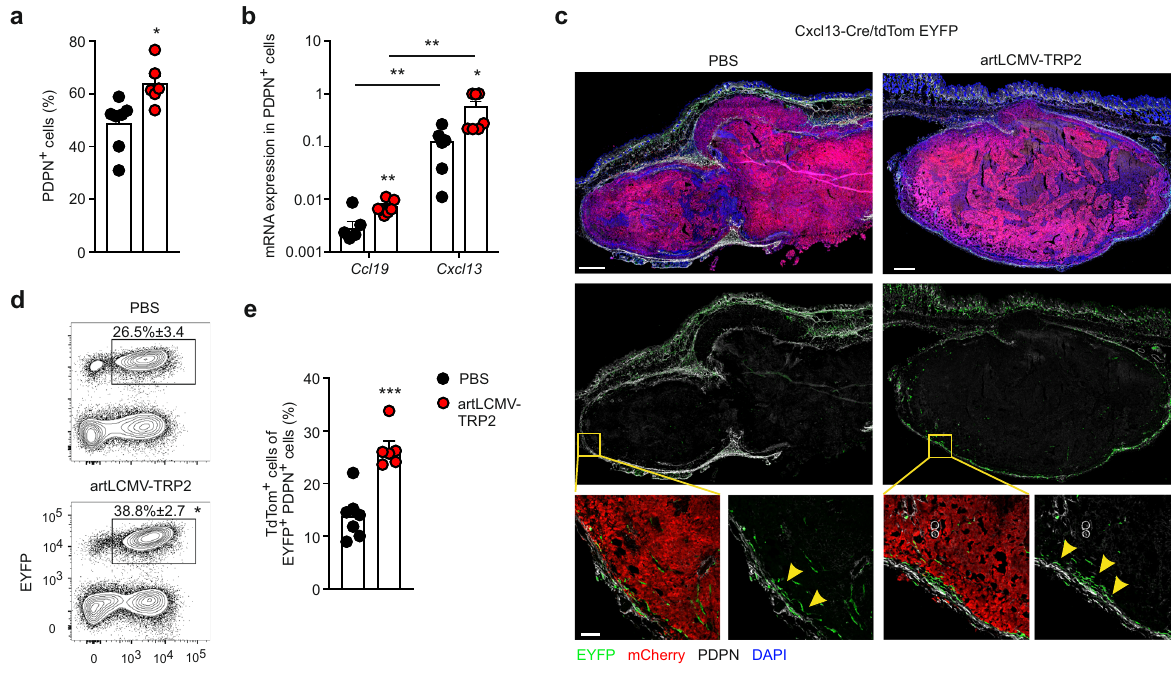
Fig. 4 artLCMV treatment induces Cxcl13 -expressing FSCs in the TME. Mice were inoculated with B16F10-mCherry and immunized i.t. on day 7 with artLCMV-TRP2 and tumors were analyzed on day 11. a Frequency of PDPN + cells in tumors from mice treated i.t. with artLCMV-TRP2. b Quantitative real- time PCR for Ccl19 and Cxcl13 mRNA expression in PDPN + FSCs sorted from tumors on day 11. c Confocal microscopy of tumors from Cxcl13-Cre/tdTom EYFP mice treated as indicated. Scale bars 700 μ m (overview) and 80 μ m (boxed areas). Arrowheads indicate EYFP + PDPN + FSCs. d Frequency of EYFP + PDPN + in Cxcl13-Cre/tdTom EYFP mice. e Frequency of tdTom + cells among EYFP + PDPN + cells as marker for current CXCL13 expression. Dots represent individual mice and lines indicate mean values± s.e.m values. Pooled data from two independent experiments with n = 7 (PBS) and n = 6 (artLCMV-TRP2) mice ( a , d , e ); n = 7 ( Ccl19 , PBS; Ccl19 , artLCMV-TRP2; Cxcl13 , artLCMV-TRP2) and n = 6 ( Cxcl13 , PBS) mice ( b ). Representative images from n = 4 (PBS) and n = 5 (artLCMV-TRP2) mice ( c ). Statistical analysis was performed using unpaired two-tailed Student ’ s t test ( a , b , d , e ) with * P < 0.05: ** P < 0.01; *** P < 0.001. Source data and exact P values are provided in the Source data fi